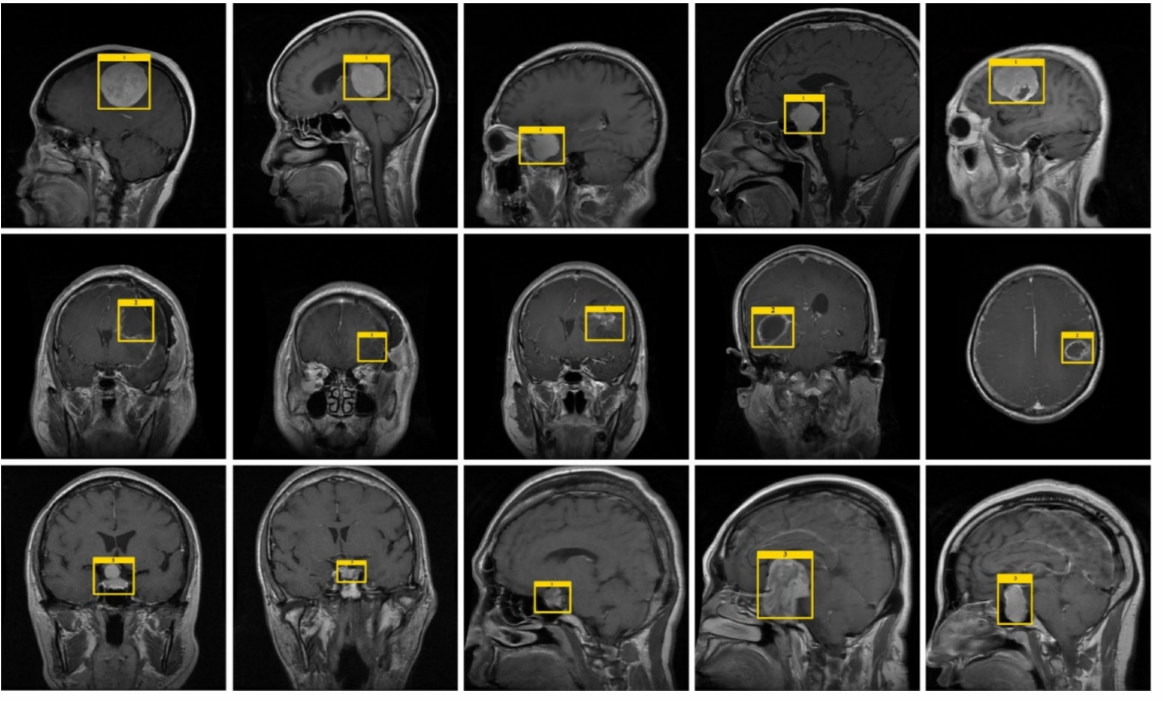
Figure 2. Sample annotated